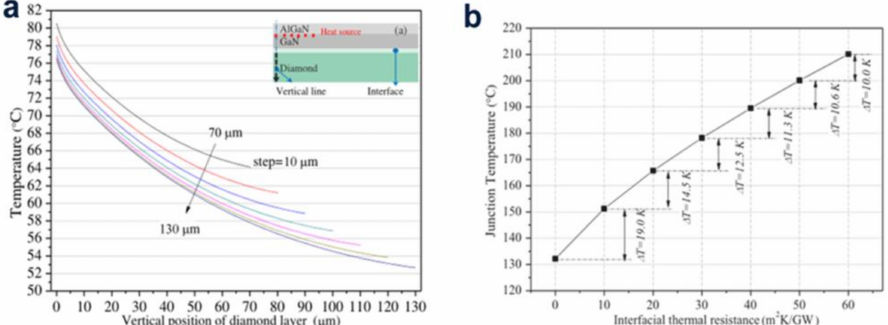
Figure 7. ( a ) Four different diamond thicknesses, ( a ) Sketch map of the perpendicular location, the temperature distribution in the perpendicular position of diamond substrate is simulated. ( b ) Re- lationship between thermal resistance of contact surface and junction temperature under some meaningful data.